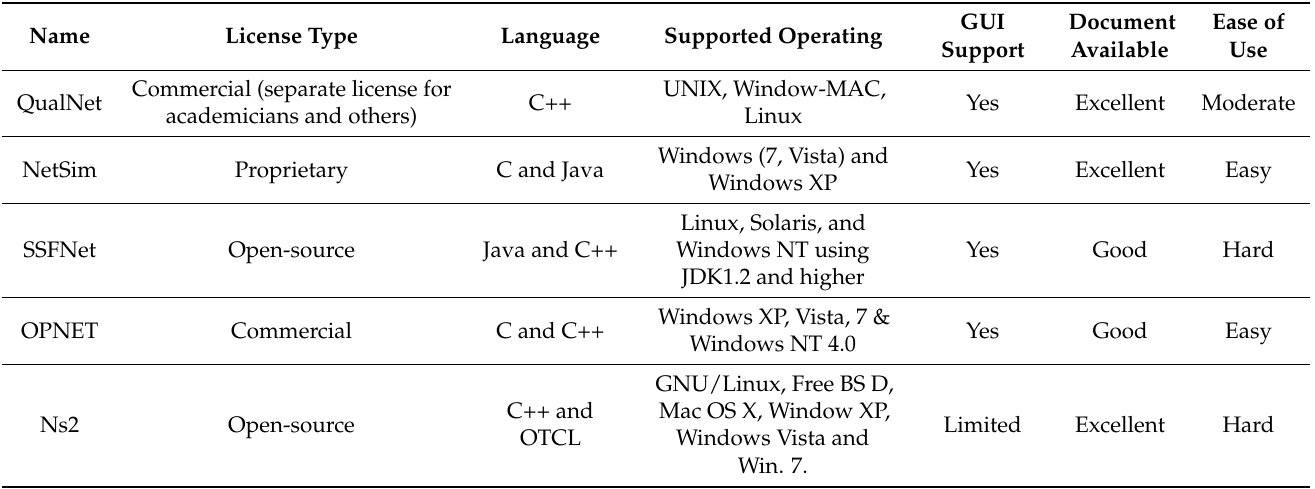
Table 1. Comparisons of some network simulation tools